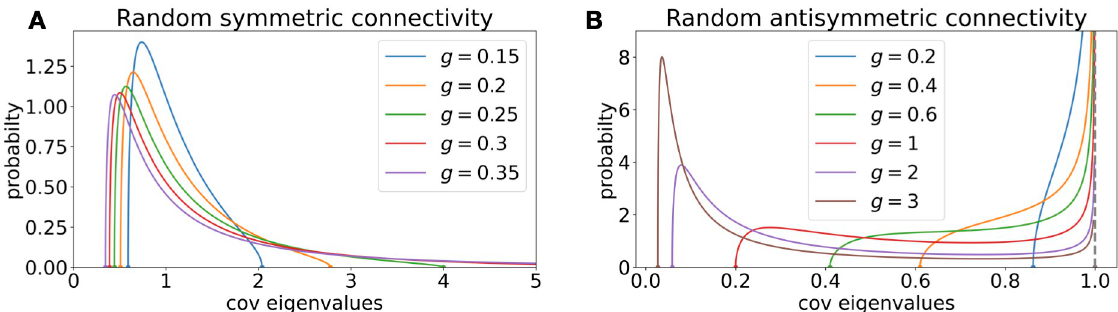
Fig 3. Covariance spectrum for the symmetric and anti-symmetric random connectivity. A. The pdf of a covariance spectrum with random symmetric J with different g (note g < 1 for stability). B. Same as A., but for random anti-symmetric J ij = − J ji . The pdf diverges at 2 x = 1 as j 1 (cid:0) x j (cid:0) 1 2